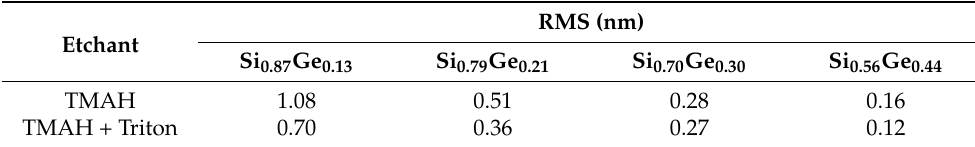
Table 2. Root mean square (RMS) values for surface roughness of Si 0.87 Ge 0.13 , Si 0.79 Ge 0.21 , Si 0.70 Ge 0.30 ,